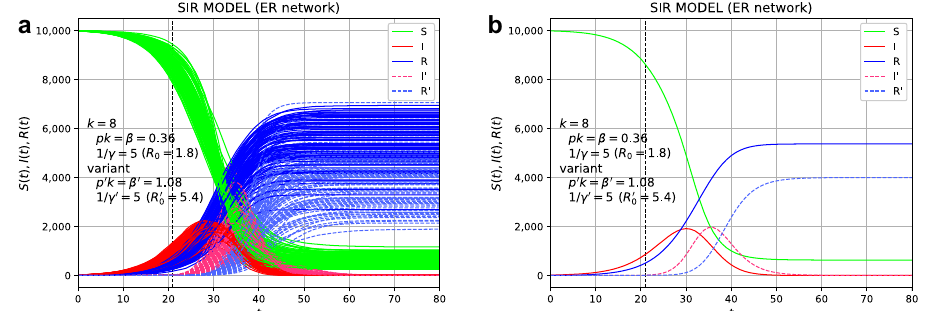
Figure 2. Effects of variants for the spread of the epidemic disease on the ER network. Suppose that 10 individuals are infected with the variant ( R ′ 0 = 5.4 ) by an external factor at t = 21 . ( a ) The plot of all 100 samples. ( b ) The average of the 100 samples. The red and blue dashed lines indicate the values of the variant.